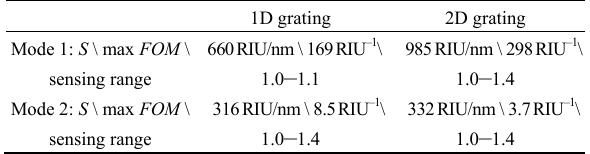
Table 1 Comparison of sensing parameters (sensitivity, maximum FOM , and sensing range) between the 1D grating composite structure and the 2D grating composite